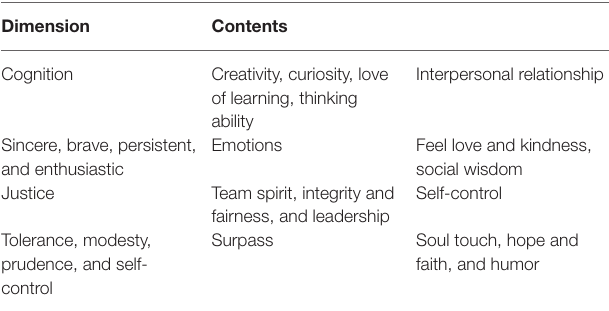
TABLE 2 | Dimensions and contents of positive psychological quality of Chinese college